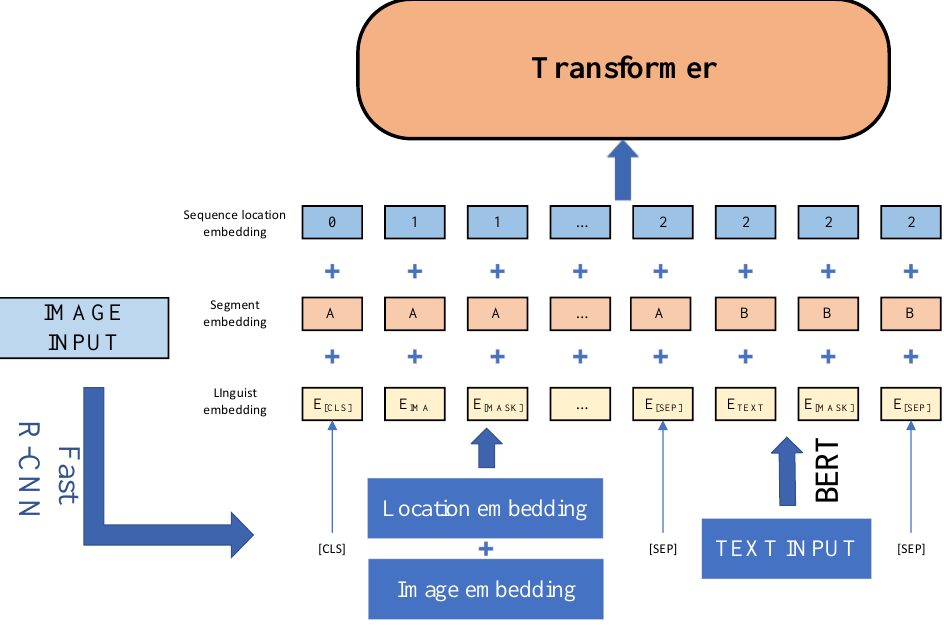
Figure 3. Schematic diagram of ImageBERT architecture. Table 3. Evaluation results of regional feature image–language pretraining model on some public datasets.